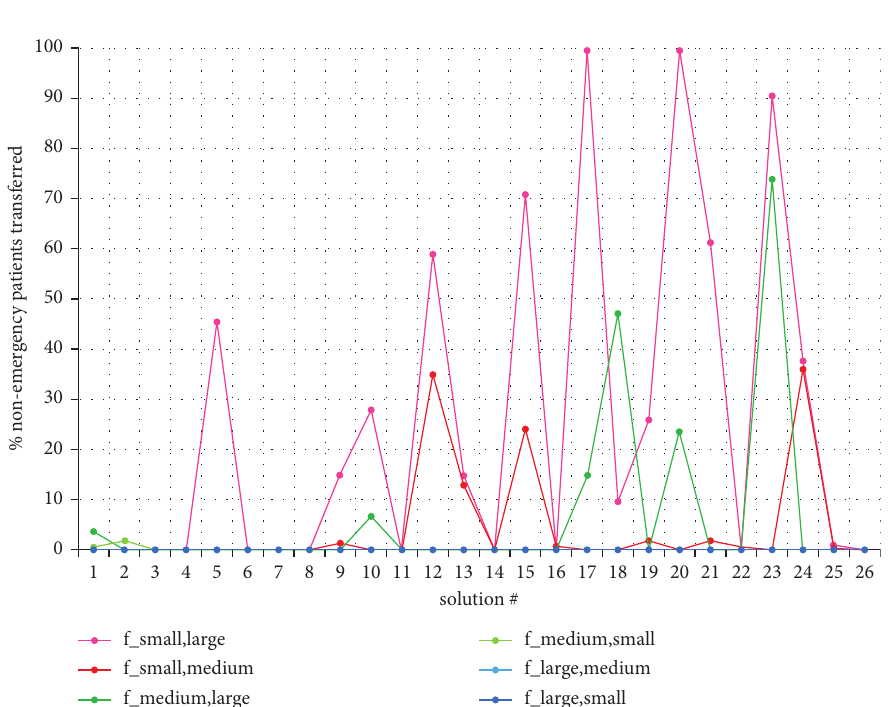
Figure 5: Percent of nonemergency patients transferred.